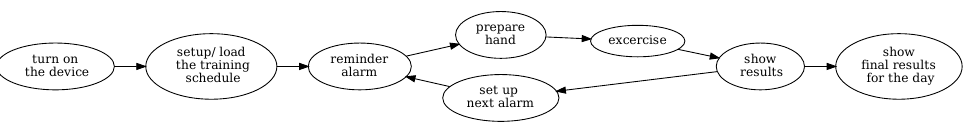
Figure 10. Diagram of the relationship between the patient, device, application, and rehabilita- tion specialist.